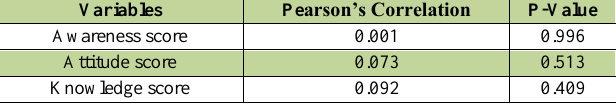
Table 3: Determination of relationship among age with awareness, attitude, and knowledge of students regarding